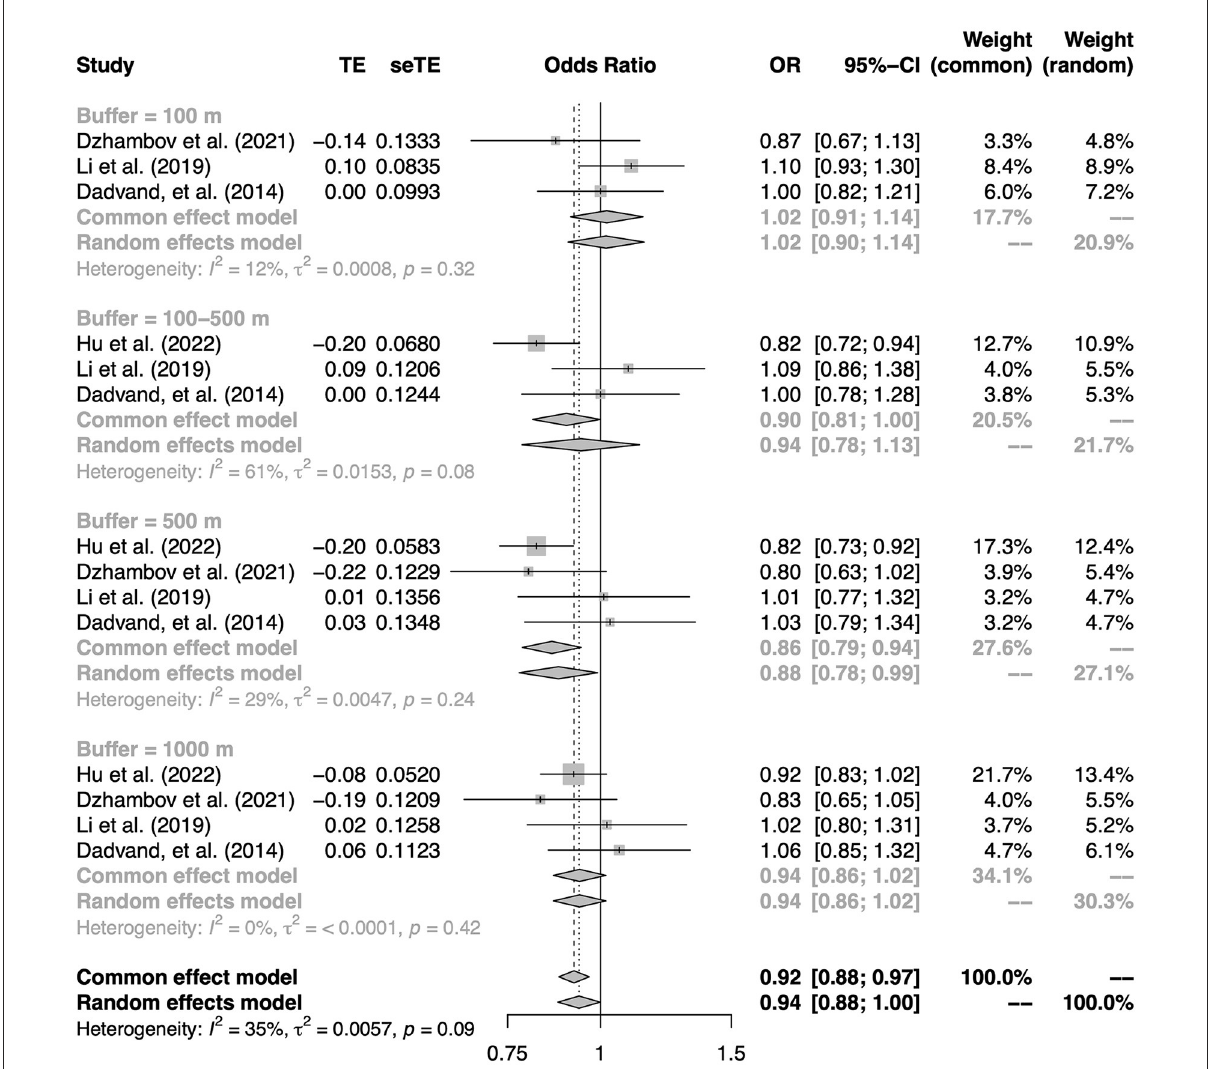
FIGURE2 The association between residential greenness and current asthma. Subgroups were defined according to the buffers of the exposure